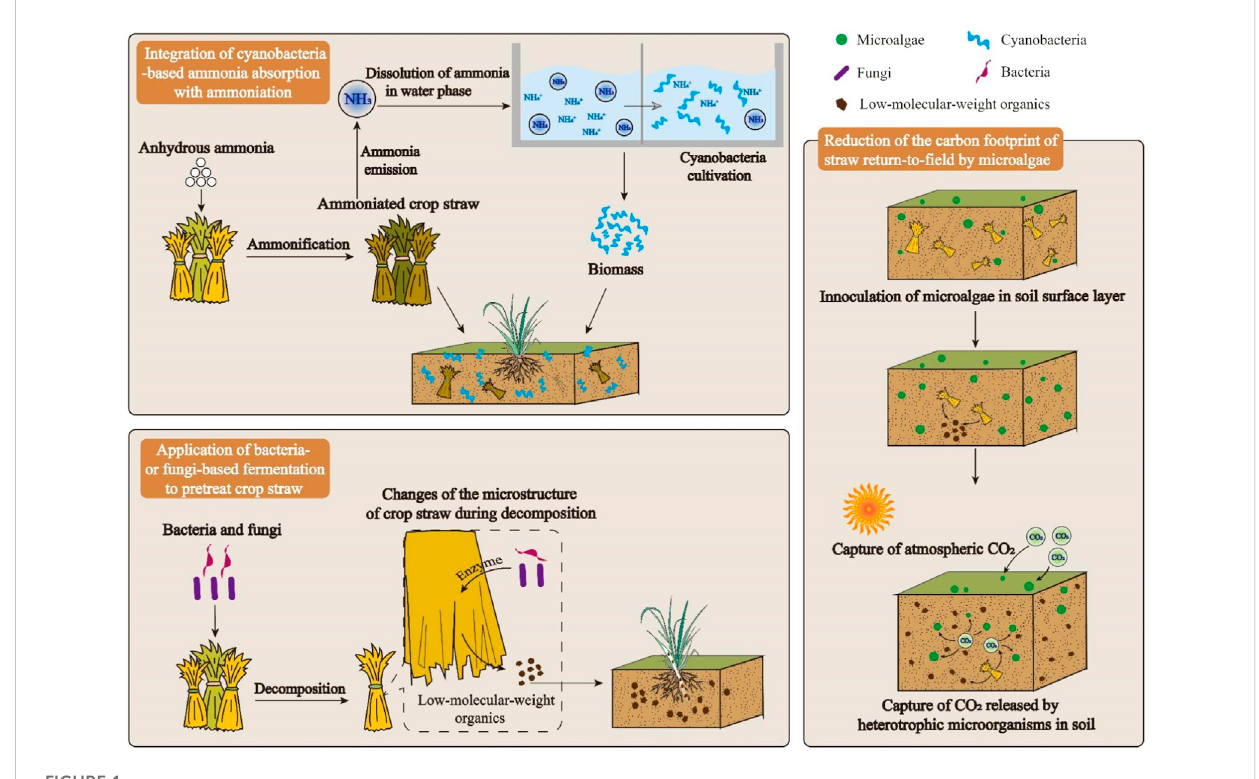
FIGURE 1 Technical roadmap for the sustainable development of straw return-to- fi